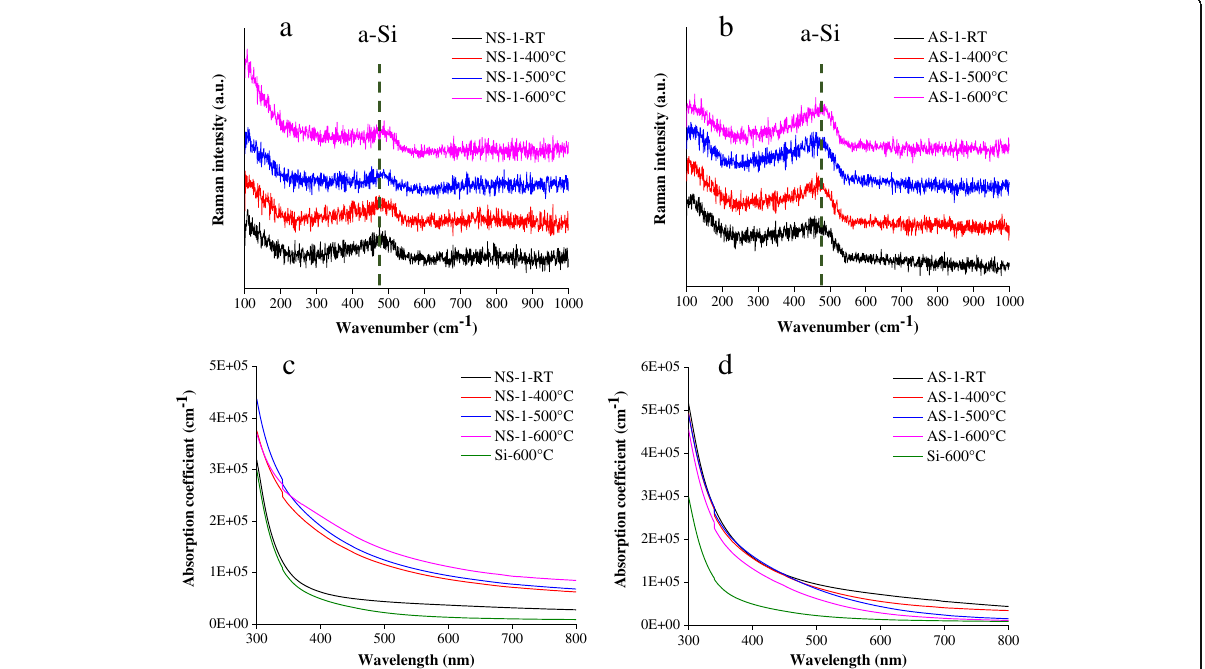
Fig. 3 Raman spectra of a NiSi/Si film and b AlSi/Si film before and after annealing in vacuum at 400, 500, and 600 °C, and the absorption coefficient of c NiSi/Si films and d AlSi/Si films annealed at different